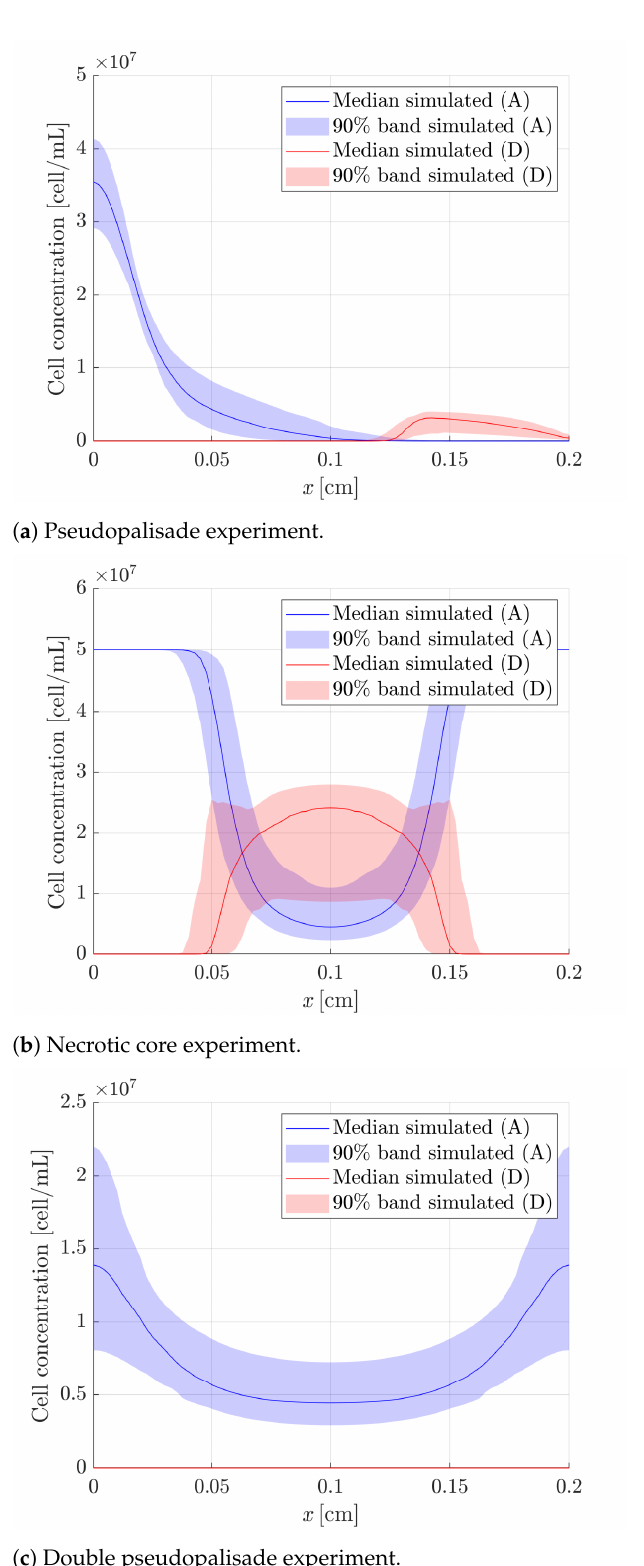
Figure 8. Distribution of the measured variable for in silico